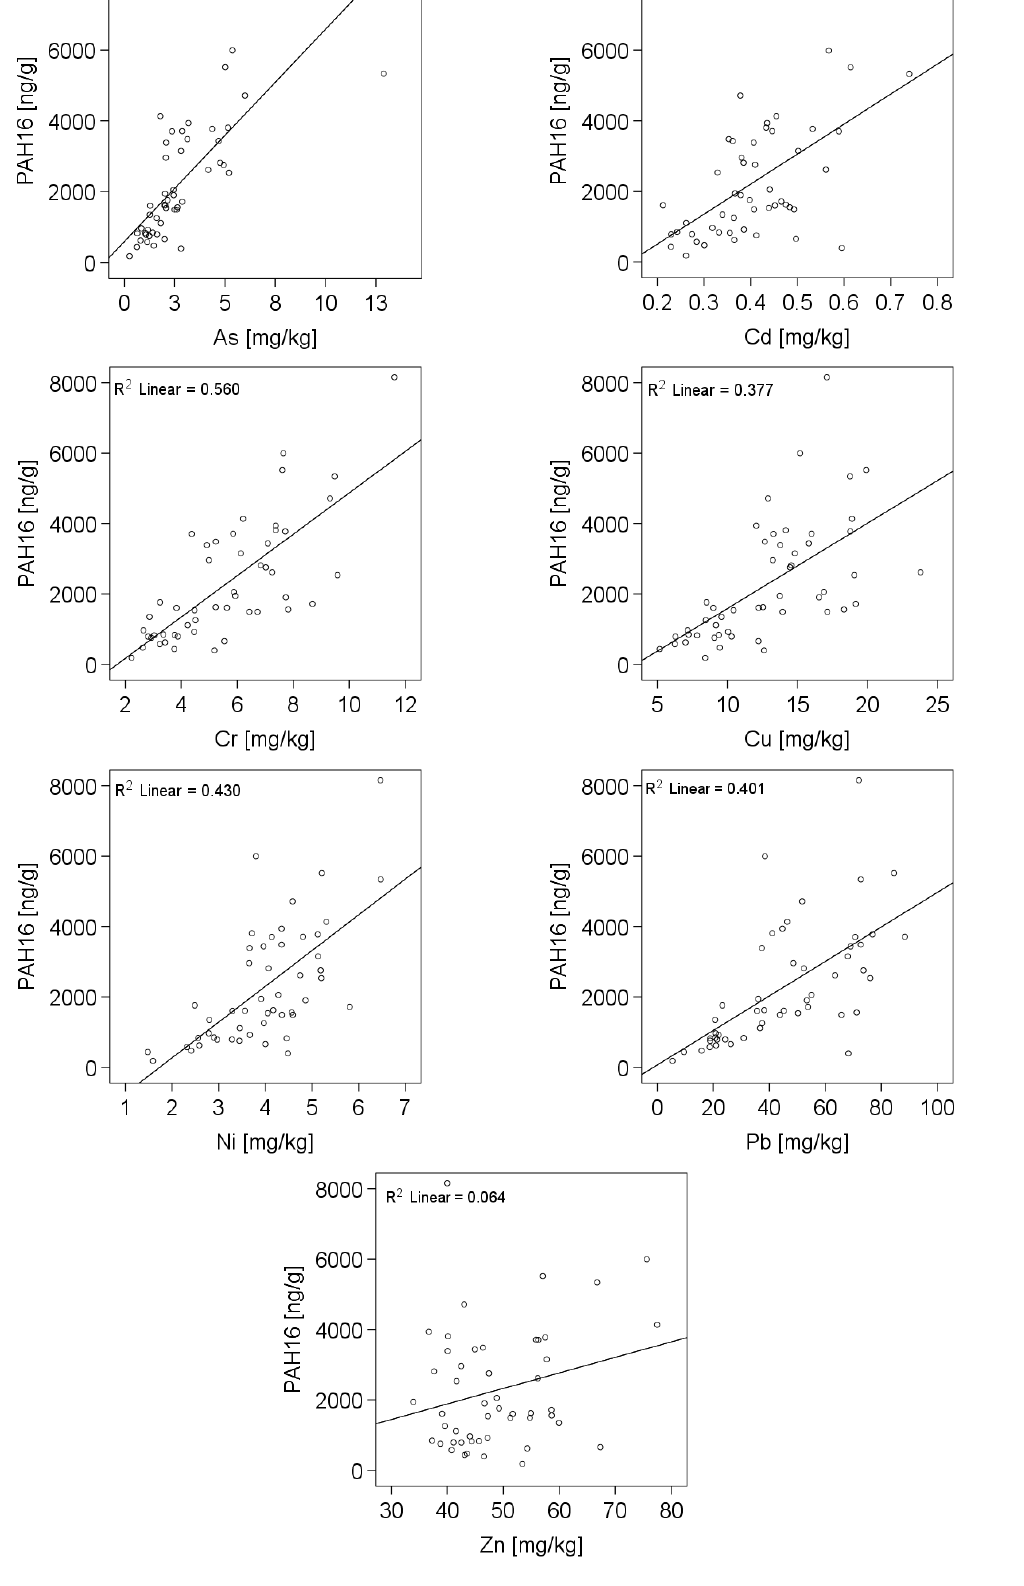
Figure 3. Scatter diagrams of the PAH 16 concentrations and As, Cd, Cr, Cu, Ni, Pb and Zn concentrations in the humus layer of NFSI sites in Brandenburg (NFSI-2), and regression